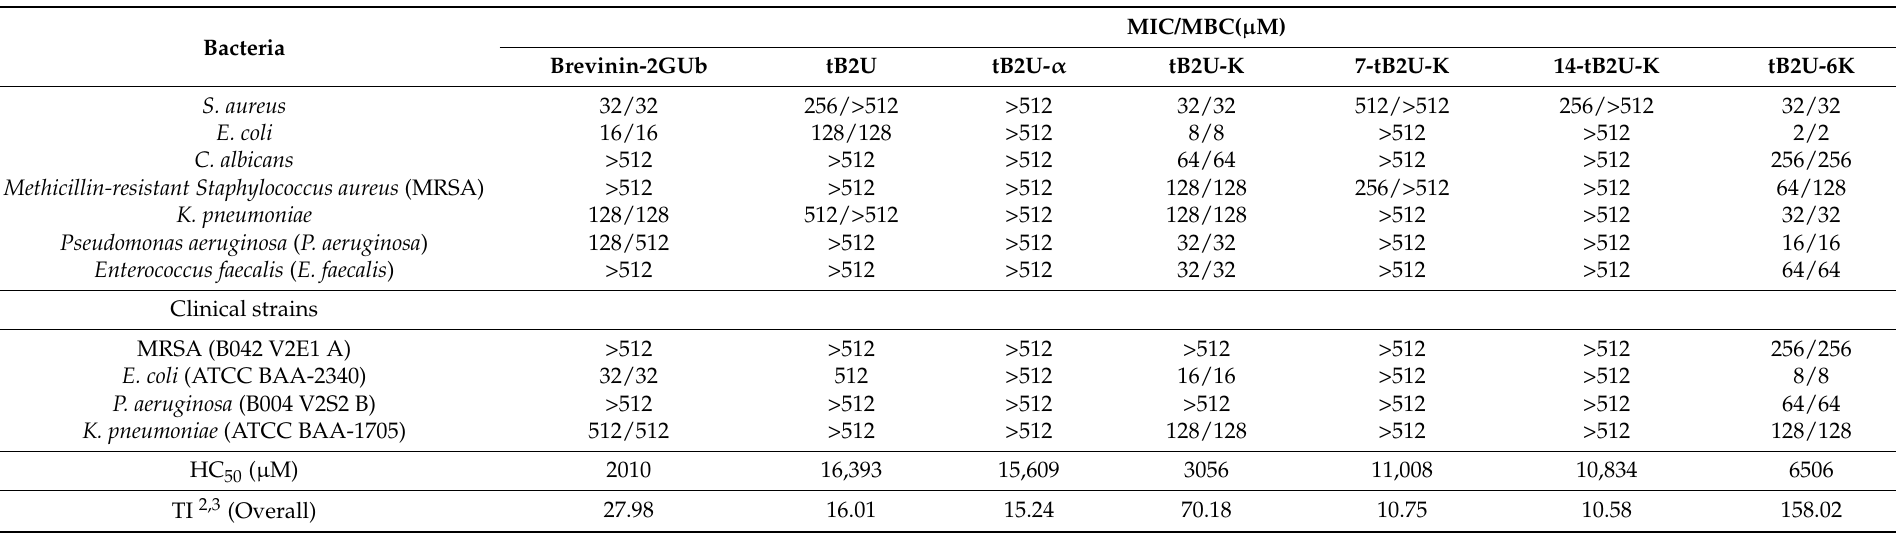
Table 3. The MICs and MBCs of Brevinin-2GUb and its analogues 1